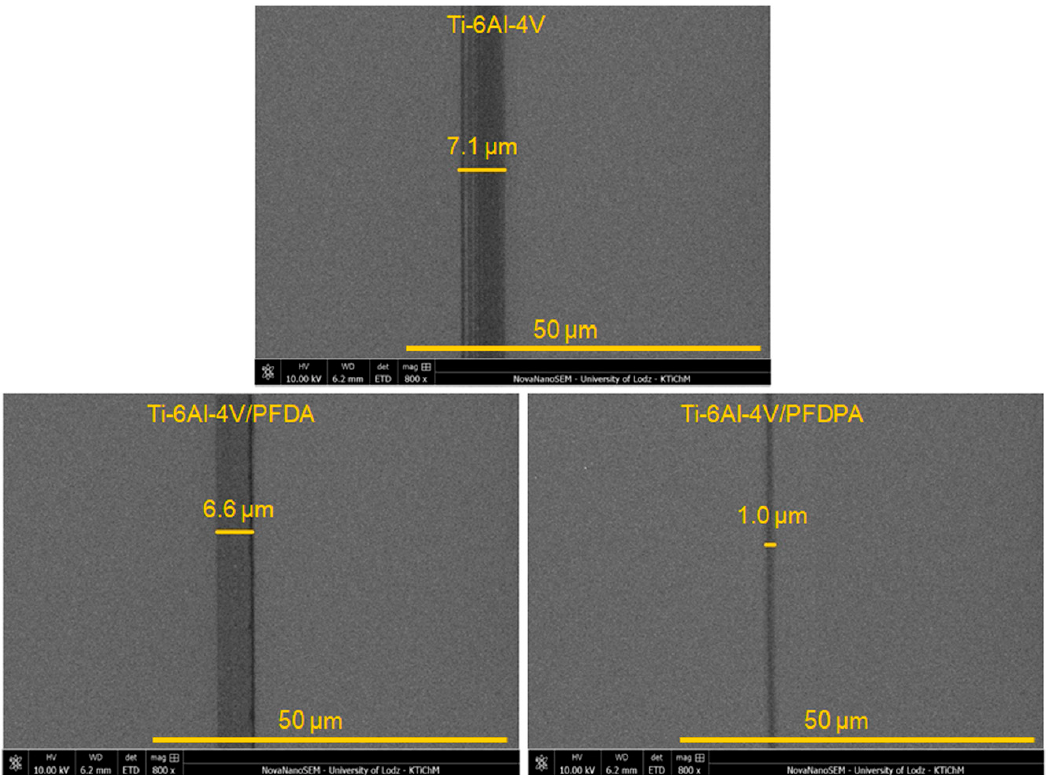
Figure 10. The images of the wear tracks after the tribology test at the microscale on the Ti-6Al-4V surface before and after